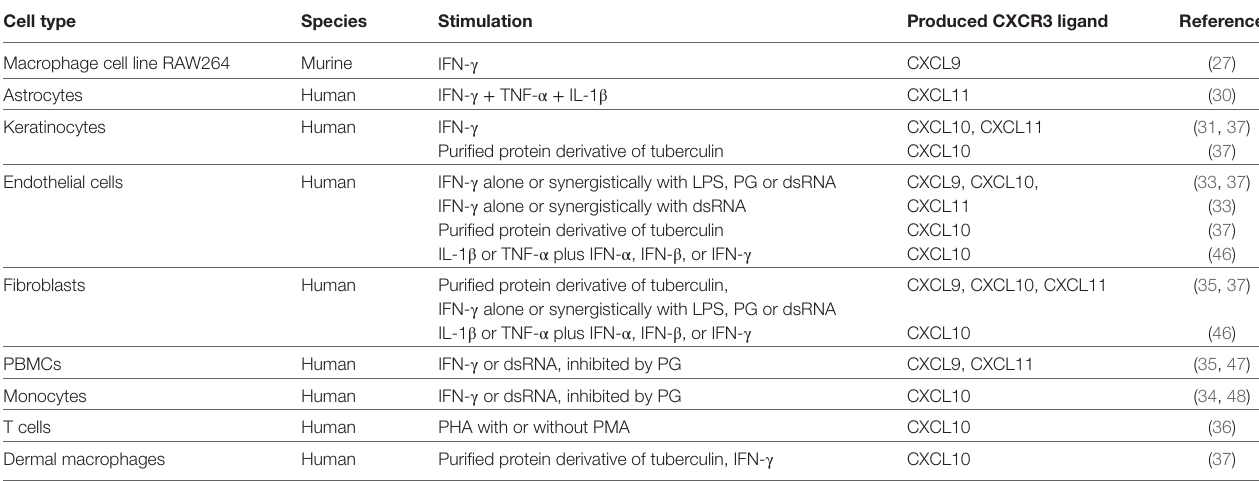
TABLe 1 | Major sources of natural IFN-inducible CXCR3